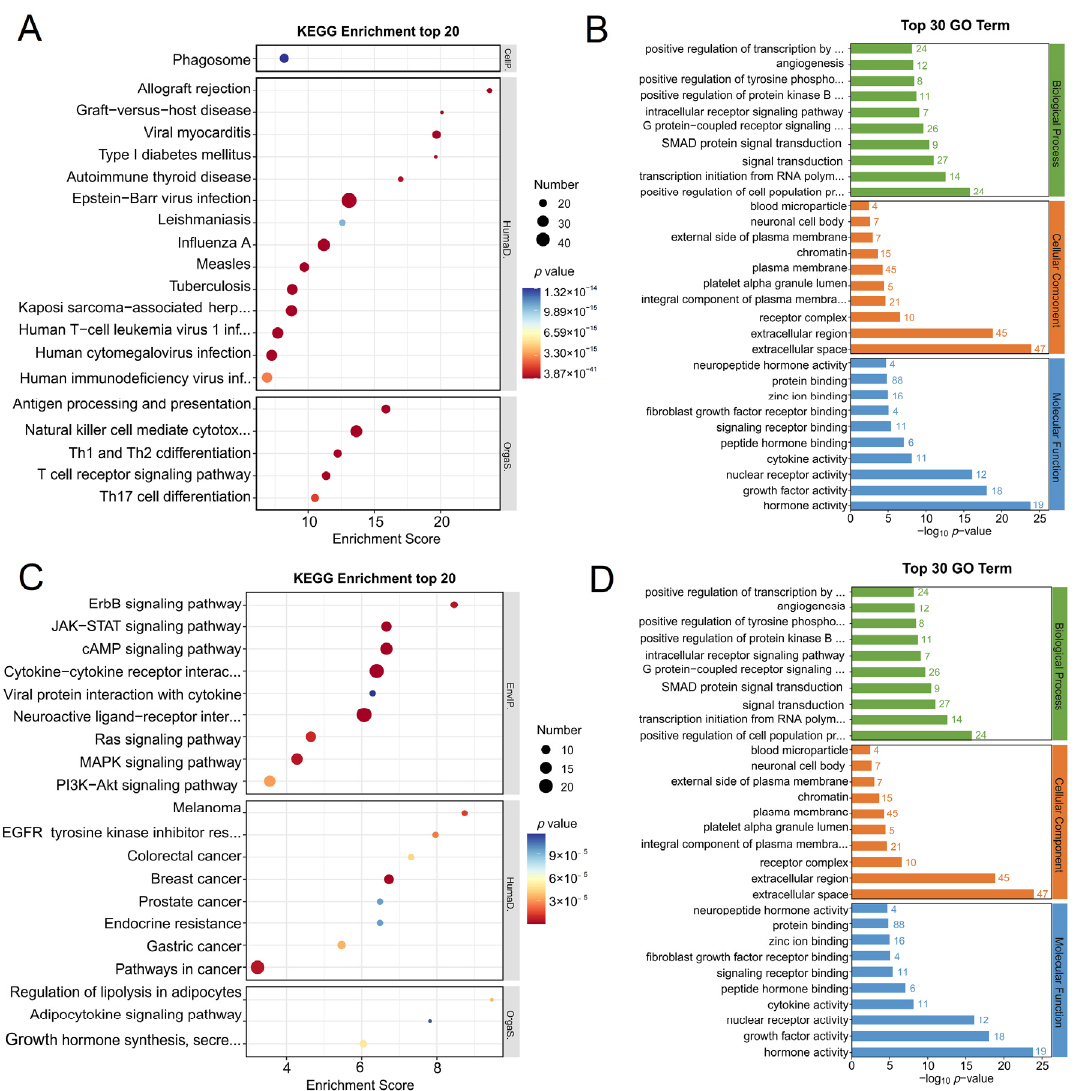
Figure 3. Enrichment analysis. ( A ) KEGG enrichment analysis of 170 common up-regulated DIRGs in data 1 and data 2. ( B ) GO enrichment analysis of 170 common up-regulated DIRGs in data 1 and data 2. ( C ) KEGG enrichment analysis of 104 common down-regulated DIRGs in data 1 and data 2. ( D ) GO enrichment analysis of 104 common down-regulated DIRGs in data 1 and data 2. The numbers next to the bars represent the number of genes enriched in the GO